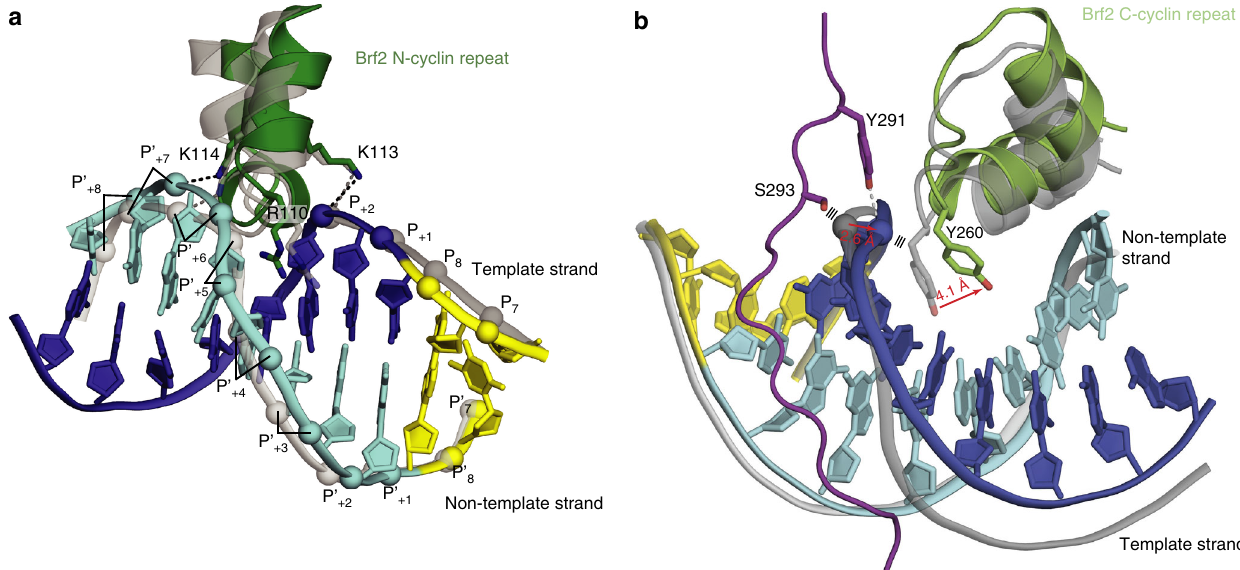
Fig. 2 Structural rearrangement of Brf2 N-cyclin and C-cyclin repeats upon Bdp1 binding. a In presence of Bdp1, the Brf2 N-cyclin repeat (depicted in green ) is rearranged when compared to the Brf2 – TBP – DNA structure (PDB id:4ROC, depicted in gray ) causing a shift of one nucleobase in the non-template strand (in cyan ). The template strand (in blue ) is held in place by interactions with Brf2 K113 and R110. The TATA box is depicted in yellow . b The Bdp1 linker rearranges the phosphate backbone of the DNA template strand causing the Brf2 C-cyclin repeat (depicted in green ) to move away when compared to the Brf2 – TBP – DNA structure (depicted in gray